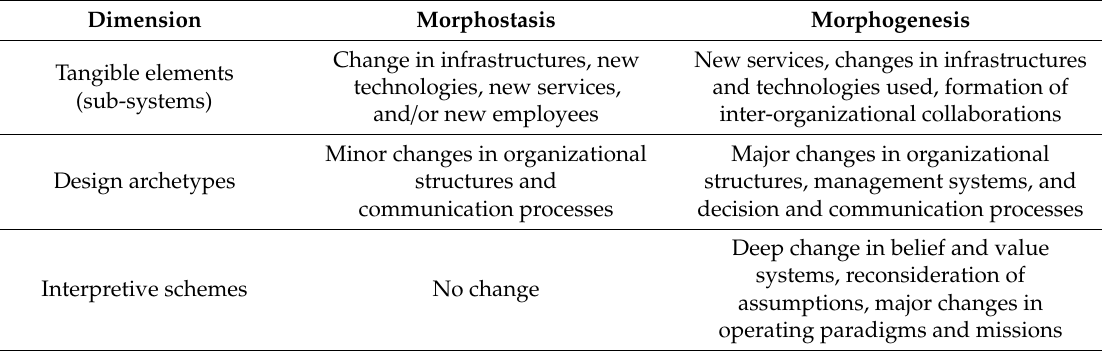
Table 2. E ff ects of morphostatic and morphogenetic changes on the dimensions of